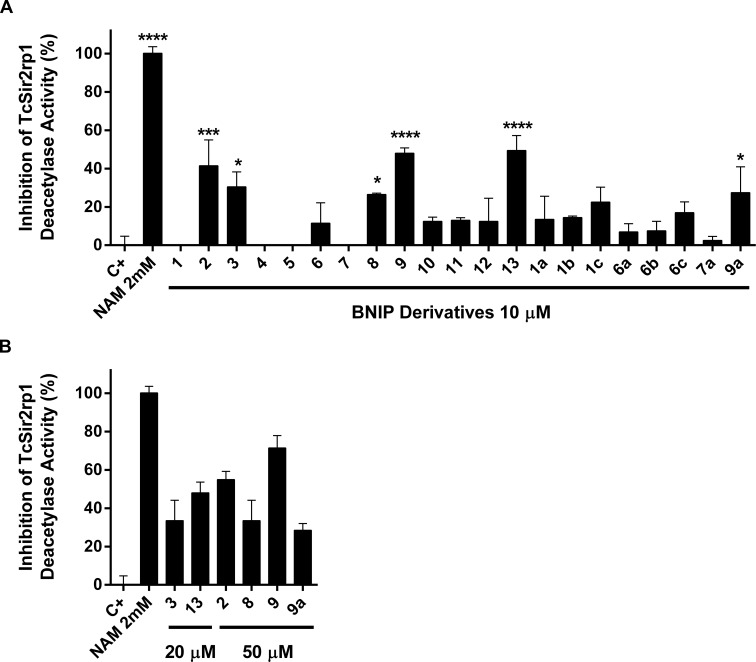
Enzymatic inhibition of TcSir2rp1 by BNIP derivatives.A-B) The percentage of inhibition of the NAD+-dependent deacetylase activity of TcSir2rp1 by BNIP derivatives is represented in the y axis. Positive (no drug) and negative (NAM, nicotinamide at 2 mM) controls are represented. Bars represent the average + standard deviation of at least two independent experiments. Differences between the experimental groups were considered significant as follows: * p<0.05, *** p<0.001 and **** p<0.0001.